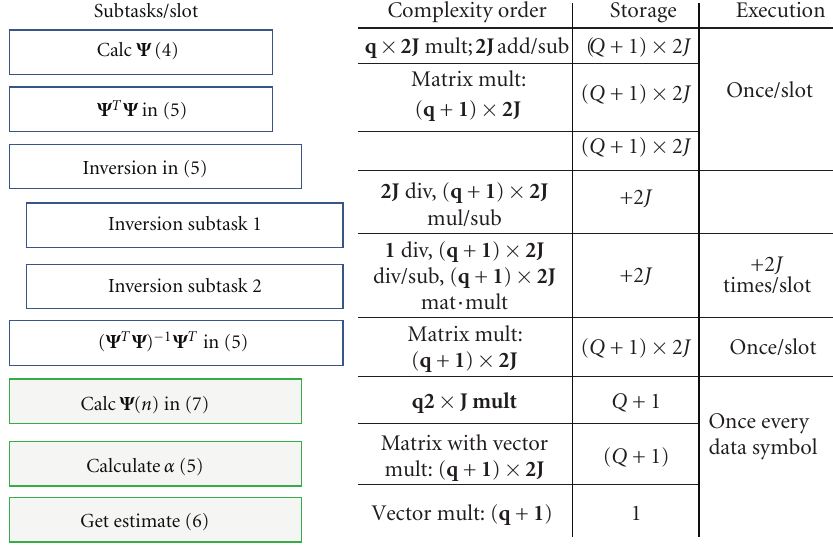
Figure 2: PI details and